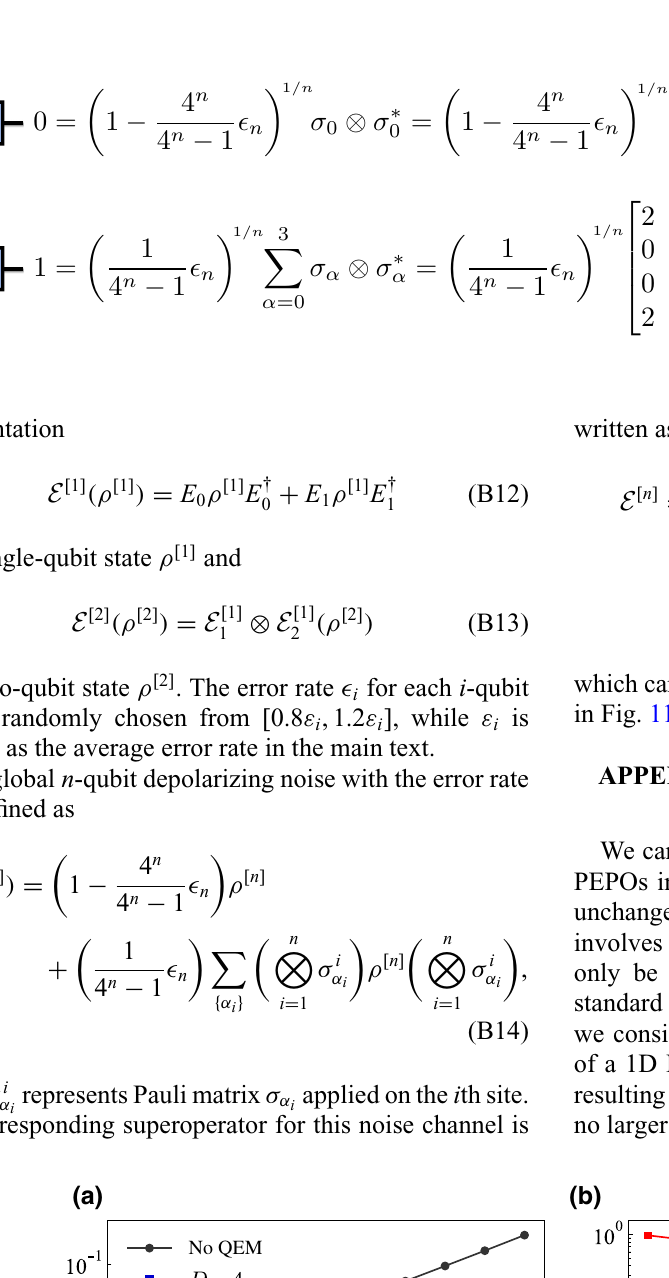
FIG. 12. Variational PEPO-inverse method. (a) Plot of D ( U − 1 total noise effect in the original circuit, labeled “No QEM”. (b) Plot of F Trace ( U (cid:2) ) during the